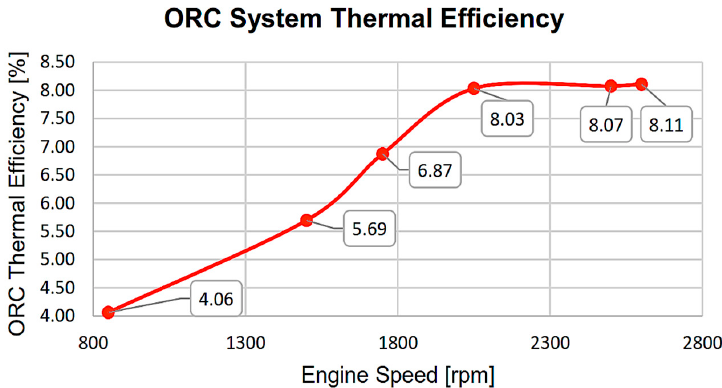
Figure 15. Thermal efficiency ORC system